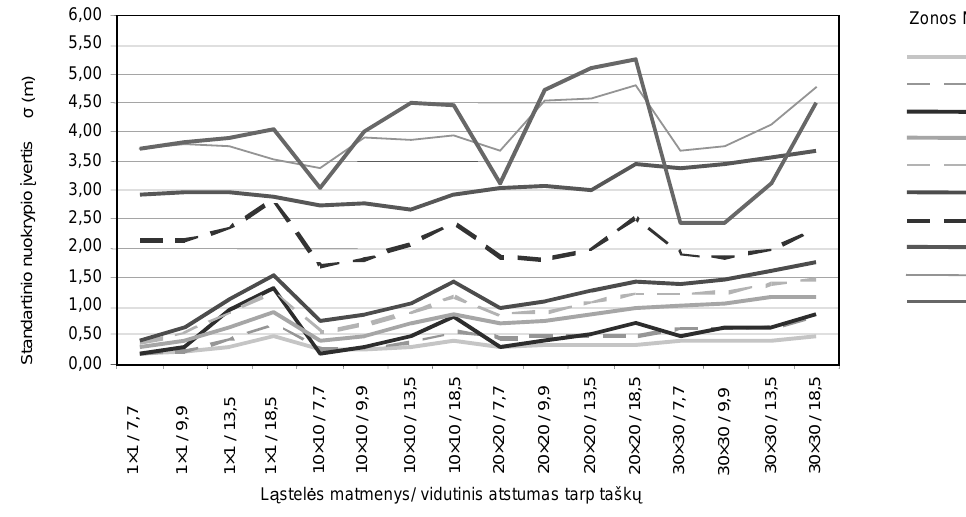
Fig 3. Accuracy analysis of DEM created by kriging method